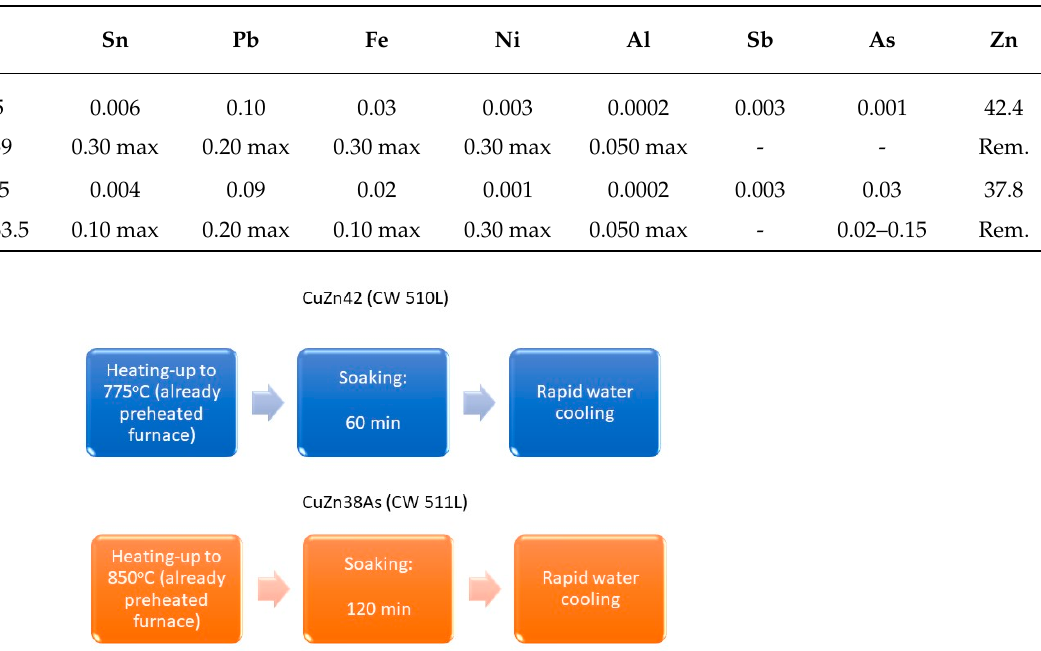
Table 1. Chemical composition of the brass alloy rods under examination (analysis by optical emission spectroscopy, elemental contents are expressed in wt.%).